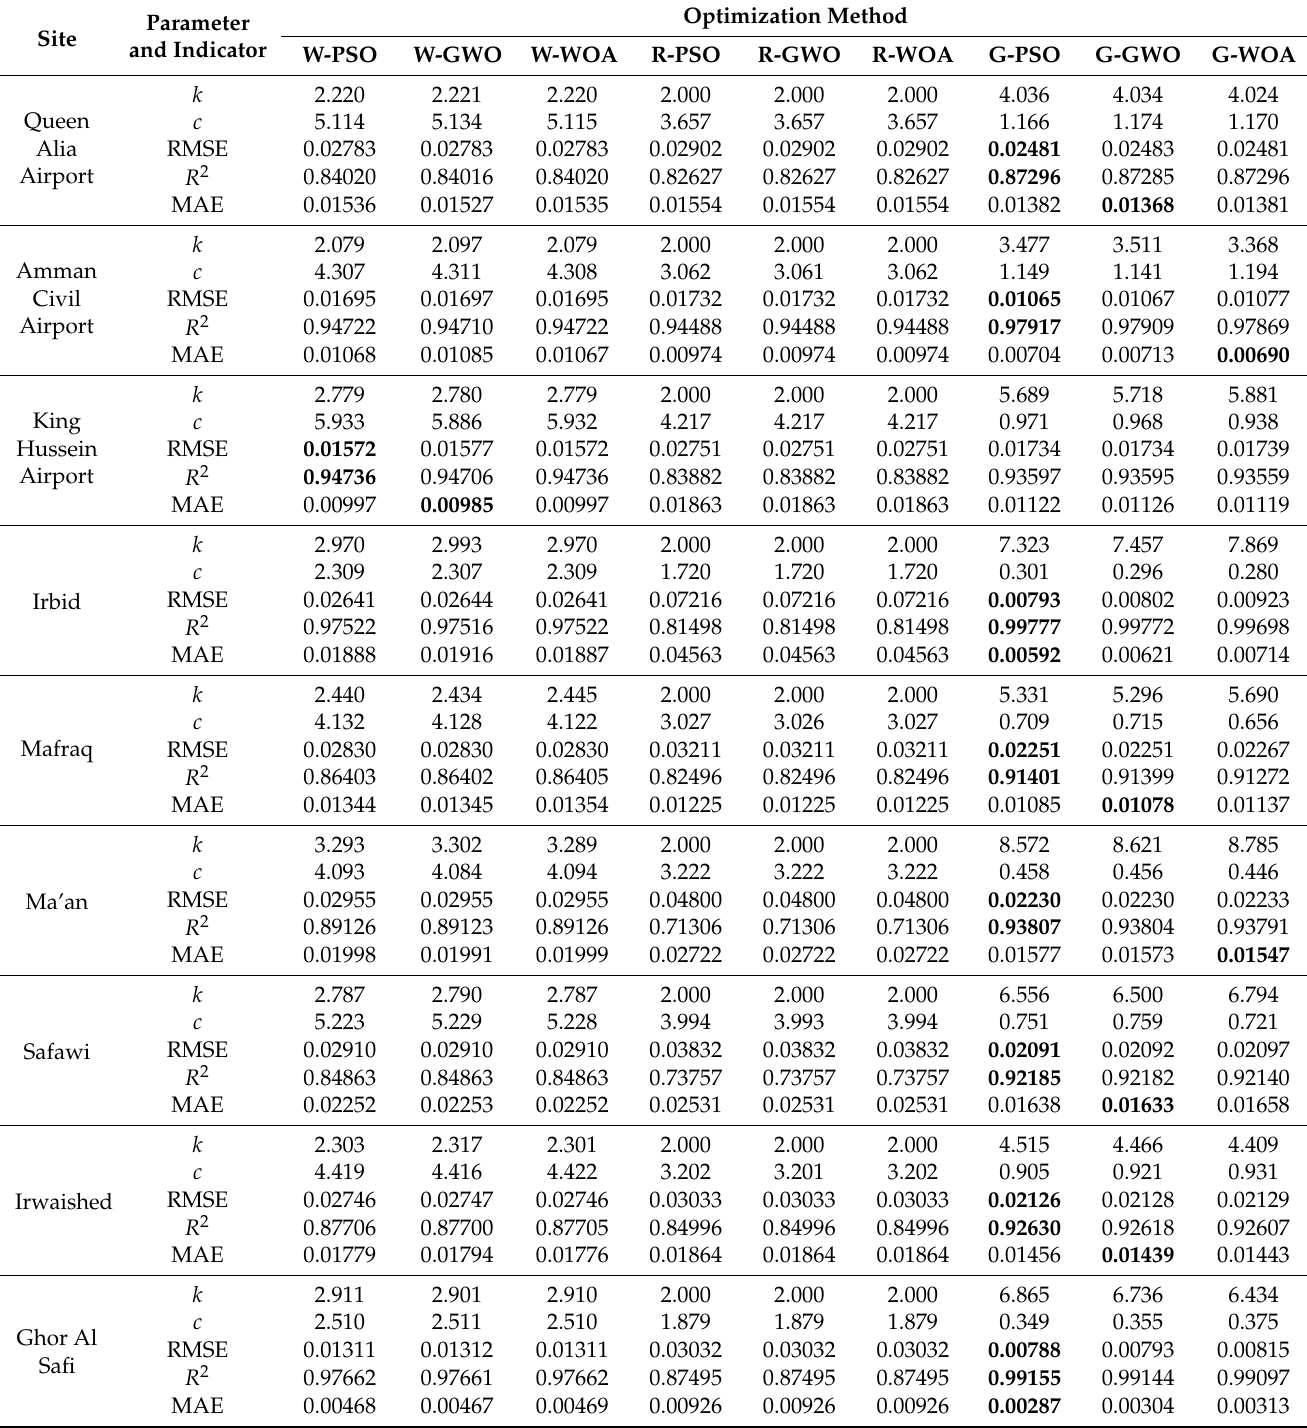
Table 4. Distribution model parameters and performance indicator results based on optimization